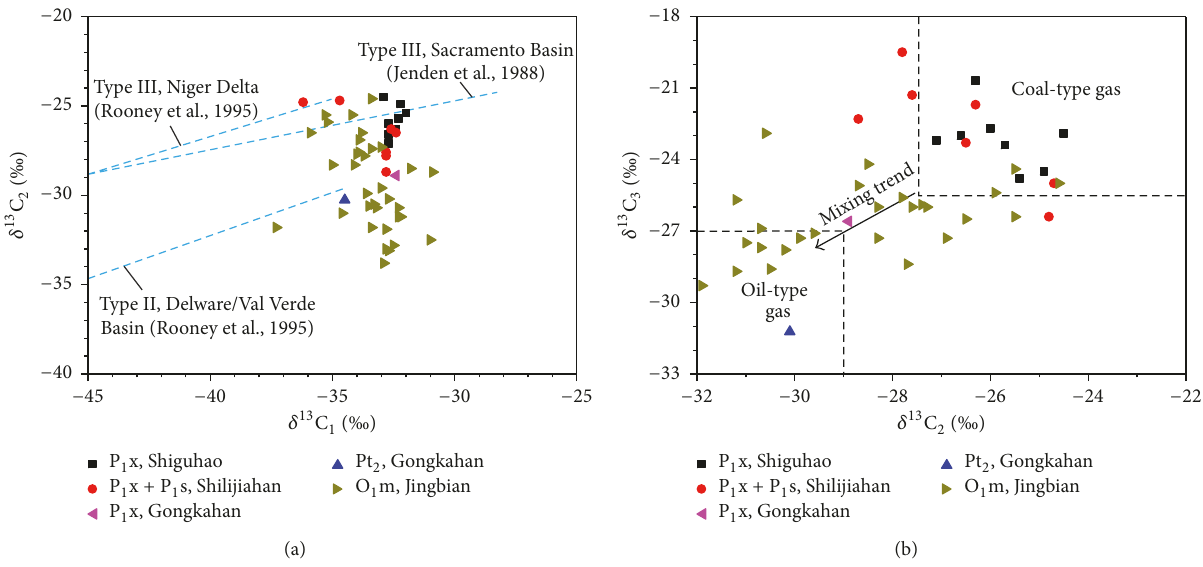
Figure 8: Cross-plots of 𝛿 13 C 2 versus 𝛿 13 C 1 (a) and 𝛿 13 C 3 versus 𝛿 13 C 2 (b) of tight gas from the Hangjinqi area. The trend lines for gases from kerogen type III of Niger Delta and kerogen type II of Delaware/Val Verde Basin are from Rooney et al. [3], and the trend lines for gas from kerogen type III of Sacramento Basin are from Jenden et al. [41]. 𝛿 13 C 2 and 𝛿 13 C 3 ranges for coal-type and oil-type gases in (b) are from Dai [42]. Data of the O 1 m gas in the Jingbian gas fields are from Dai